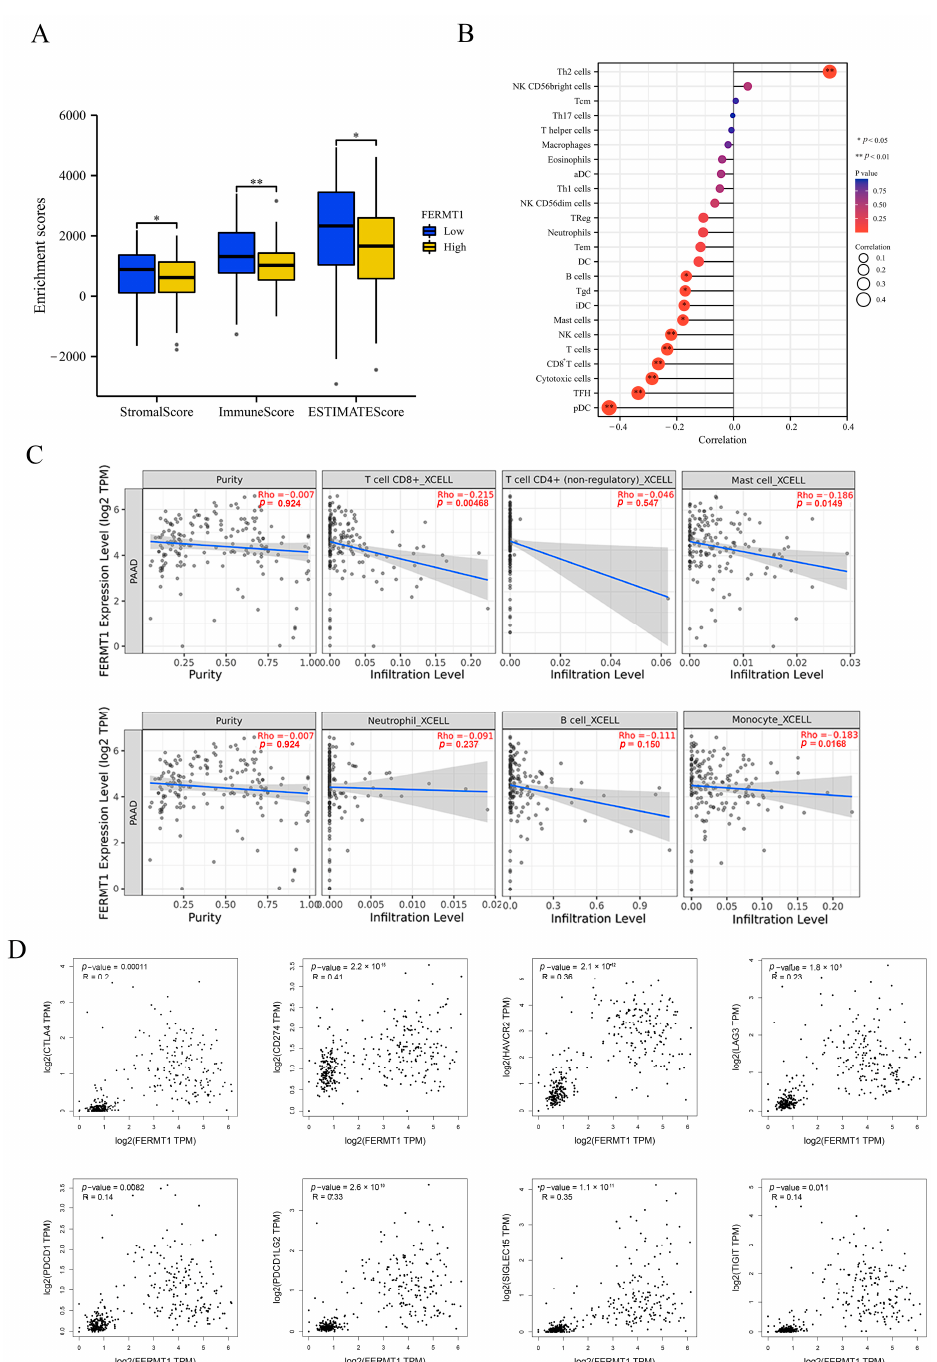
Figure 9. The relationship between FERMT1 expression and immune infiltration in PAAD. ( A ) StromalScore, ImmuneScore, and ESTIMATEScore analysis in high/low FERMT1 expression group. ( B ) Correlation between FERMT1 expression and 24 immune cell subtypes by ssGSEA. ( C ) Association between FERMT1 expression and immune cell infiltration by TIMER database. ( D ) Scatter plots showing the correlation between FERMT1 expression and eight immune checkpoint- related genes. * p < 0.005; ** p <